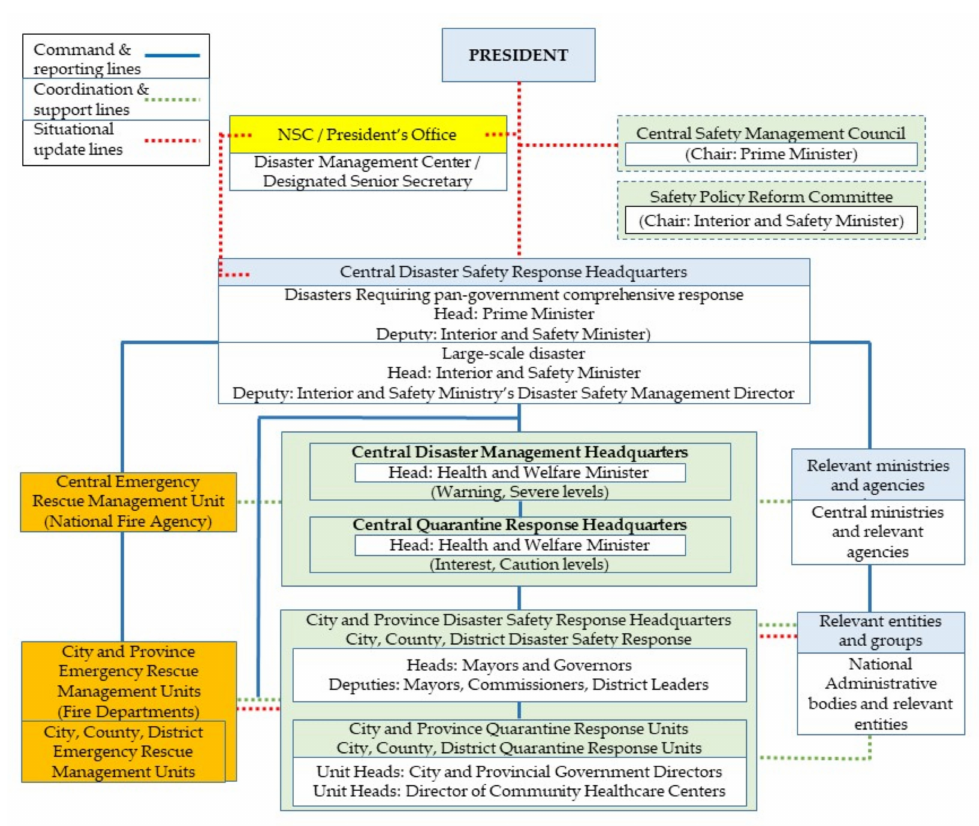
Figure 5. Disaster Management Reporting, Coordination, and Situational Updates